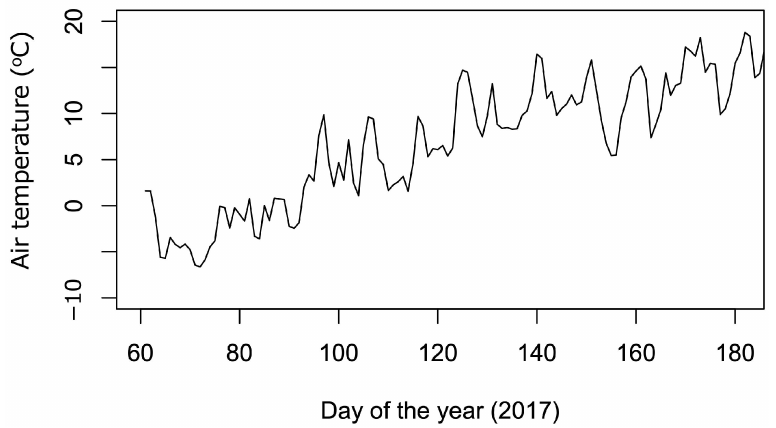
Figure 1. The daily average air temperature from March to June in the study site in 2017.